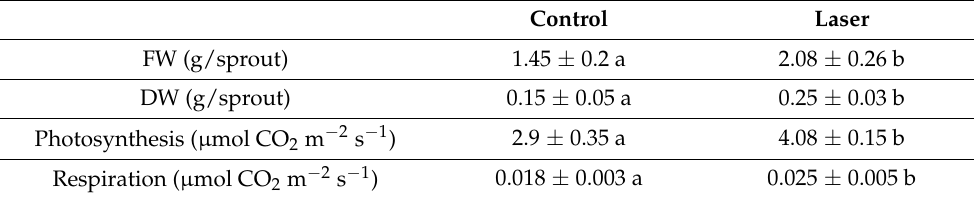
Table 2. Effect of He-Ne laser light treatment on fresh weight, dry weight, photosynthesis, and respiration levels of Cymbopogon proximus sprouts. DW: dry weight; FW: fresh weight. Data are represented by means ± standard errors. Different small letters (a, b, . . . ) above bars indicate significant differences between means at p <